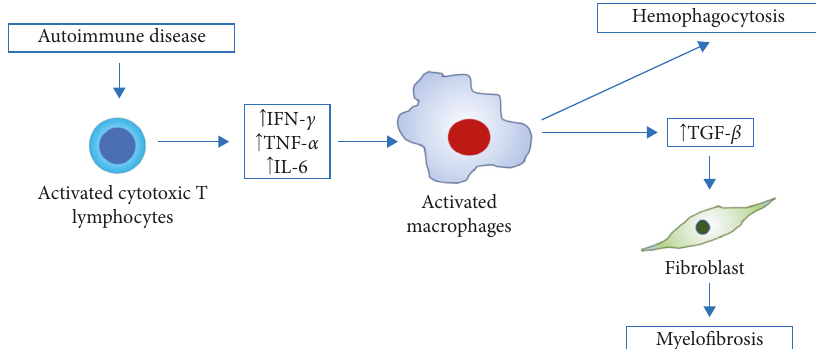
Figure 4: Possible pathogenesis of coexisting hemophagocytosis and myelofibrosis in SLE. The state of immune activation in SLE leads to excessive production of cytokines such as IFN- c , TNF- α , and IL-6. TNF- α is known to induce activation of macrophages. AAHS occurs as activated macrophages engulf mature and hematopoietic stem cells and further contribute to cytokine production. TGF- β , which is a cytokine produced by activated macrophages, stimulates fibroblast proliferation leading to